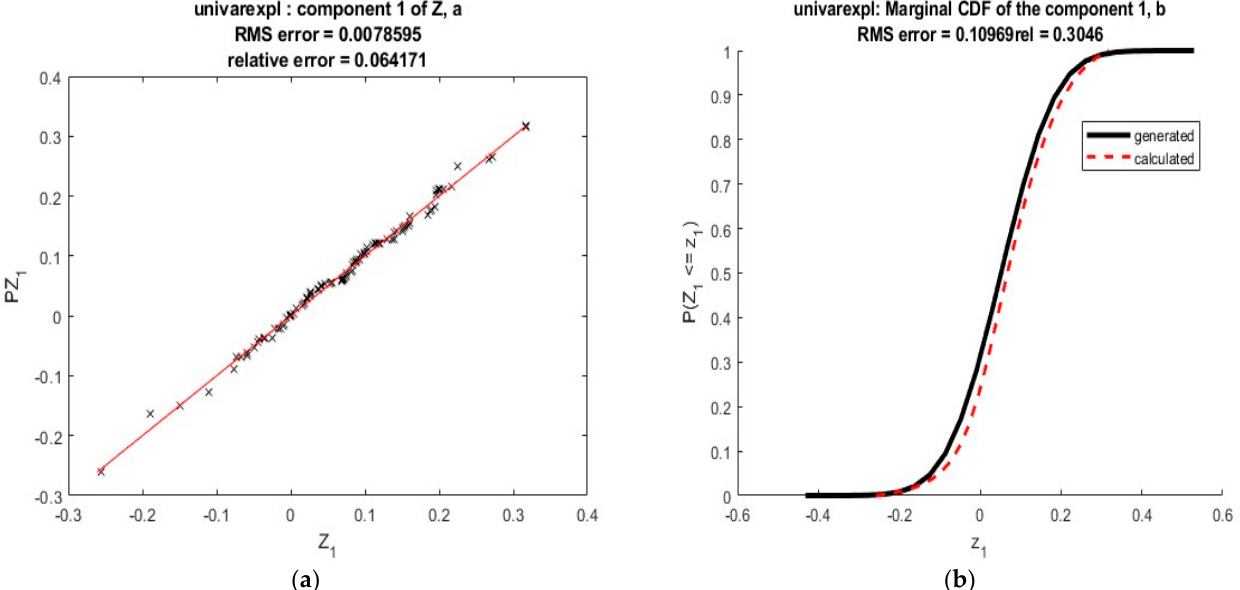
Figure 5. Gaussian variable approximated using moment matching: ( a ) polynomial expansion. ( b ) Cumulative density function. Results corresponding to a Gaussian polynomial.